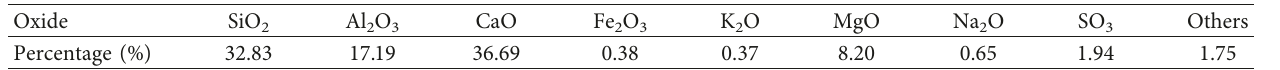
Table 1: Chemical composition of slag.